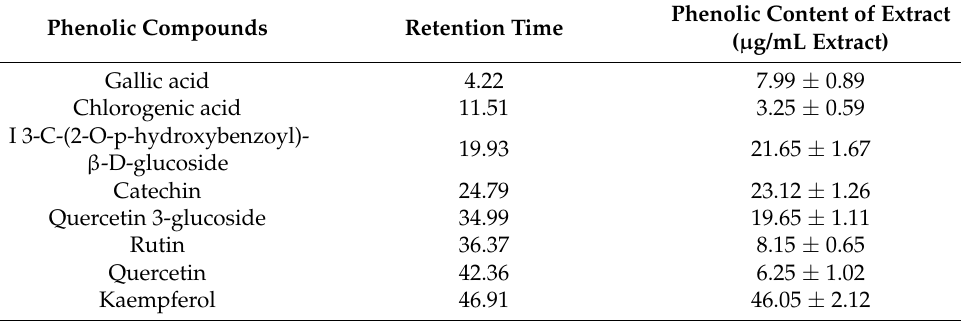
Table 2. Chemical composition of the ethanolic extract from A. muricata by HPLC (280 nm). Phenolic